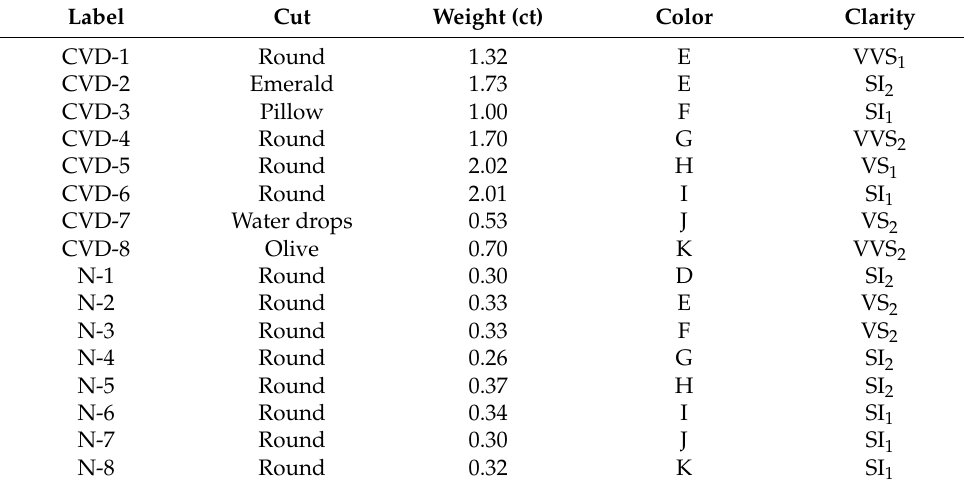
Table 1. 4C classification of CVD diamond samples and natural diamond